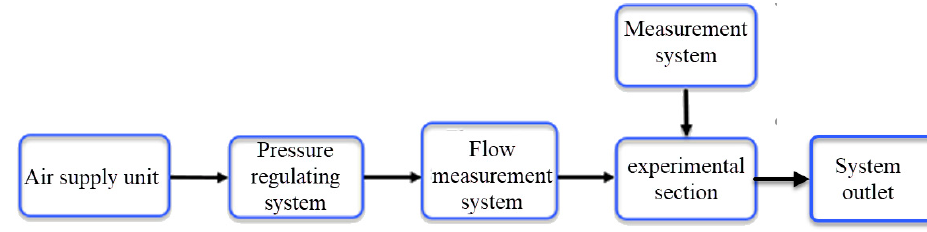
Figure 2. Schematic of the experimental